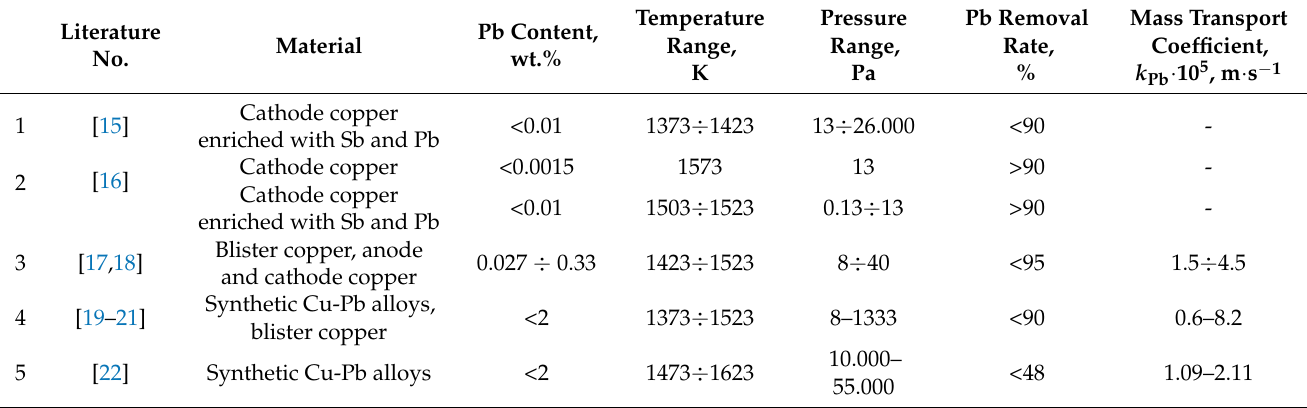
Table 1. Base parameters and results of examinations of the process of the removal of copper through refinement in vacuum induction furnaces.